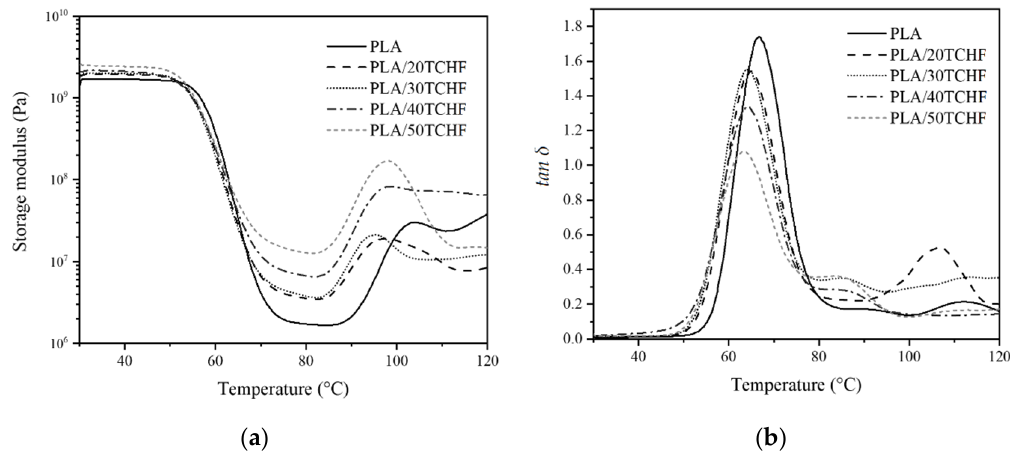
Figure 7. Evolution as a function of temperature of the ( a ) storage modulus and ( b ) dynamic damping factor ( tan δ ) of the injection-molded pieces of polylactide (PLA) with torrefied coffee husk flour (TCHF).